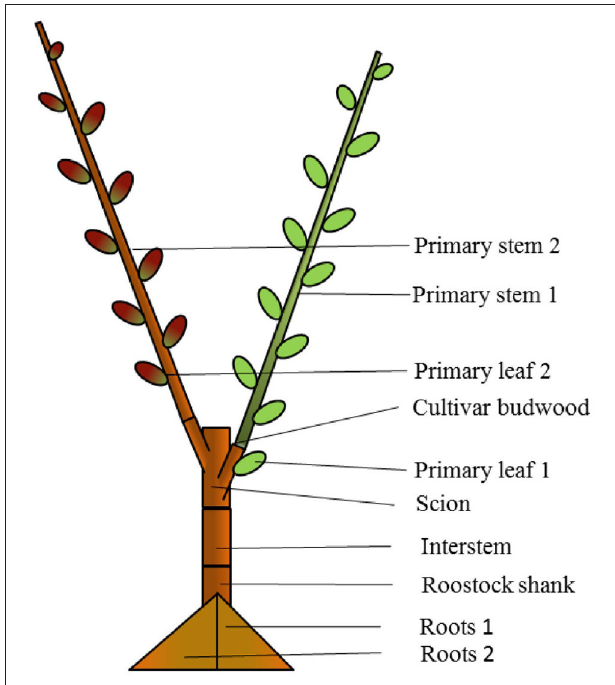
FIGURE 2 | Composition of “mixed” bi-axis (M) tree with ‘Hosui’ grafted at the lower first nodal position and ‘PremP009’ grafted at the higher second nodal position. The figure represents how the tree has been cut for obtaining the final dry weight of individual plant’s organs at growth